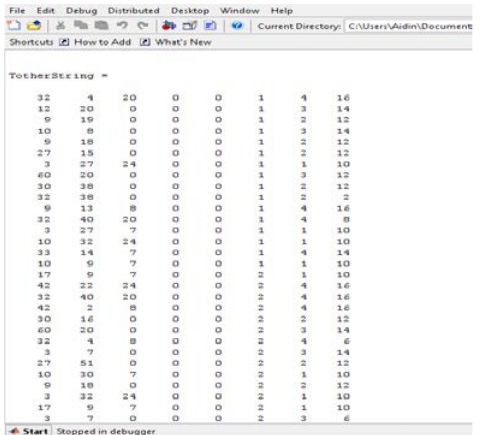
Fig. 5. Sample of using best observed layout so far as the main string (right image)